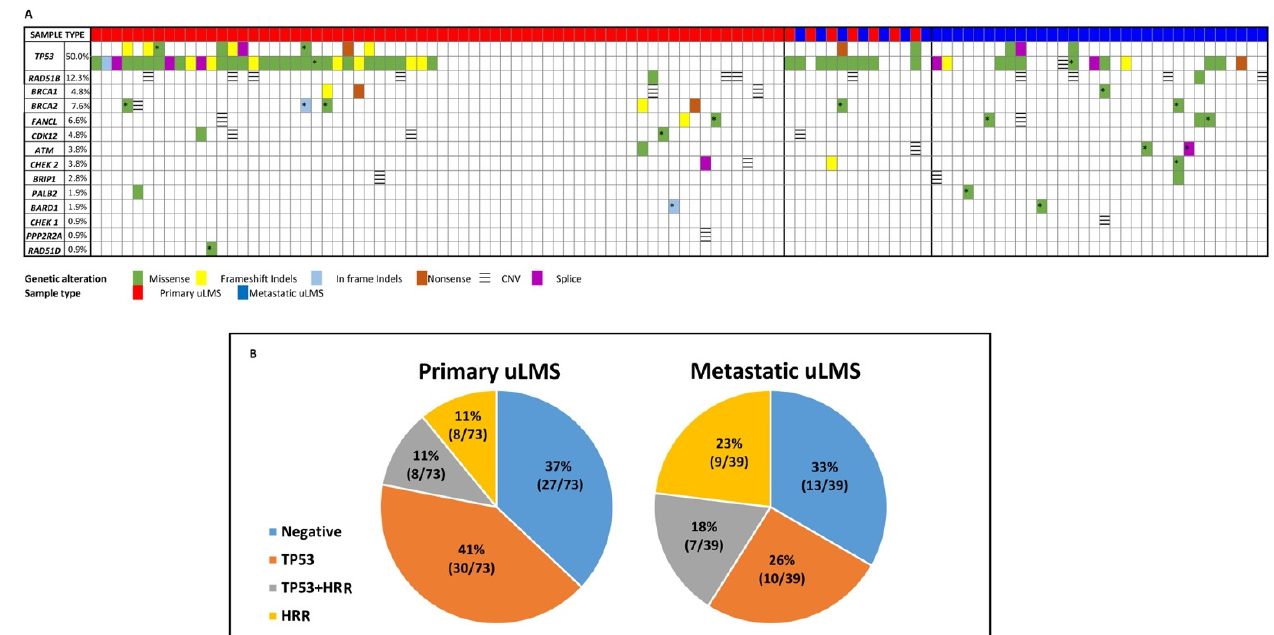
Figure 2. Molecular profile of uLMS. ( A ) Genomic alterations found in enrolled patients. For TP53, double rows represent the co-occurrence of two unique variants in the same uLMS case. ( B ) Distribution of frequencies of alterations in TP53 gene (orange), HRD-related genes (gray), and both TP53 and HRD-related genes (gold) on primary and metastatic lesions. Wild-type genes are included in the blue panel. “*” Variants of Uncertain Significance (VUSs).